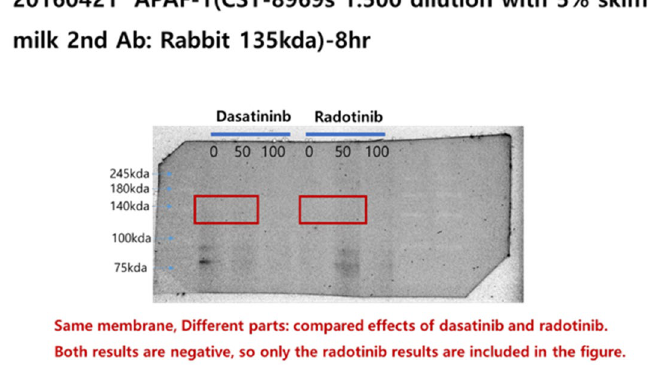
Figure 3. Original image of the membranes showing Radotinib/Apaf-1, corresponding to Fig 6A.